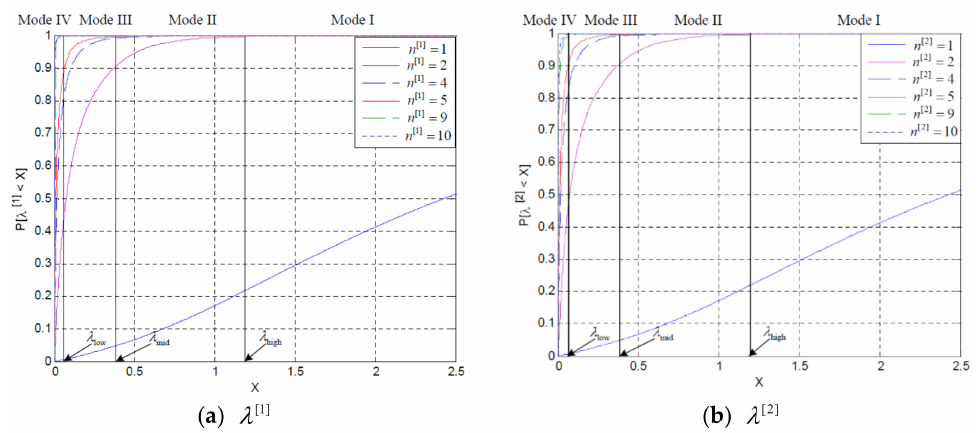
Figure 5. The cumulative distribution function (CDF) of ( a ) λ [ 1 ] and ( b ) λ [ 2 ] for the cases when n [ i ] = 1, 2, 4, 5, 9, 10, respectively, at the first detection layer (with 16 QAM and E S / N 0 = 20 dB, N = L = 4).